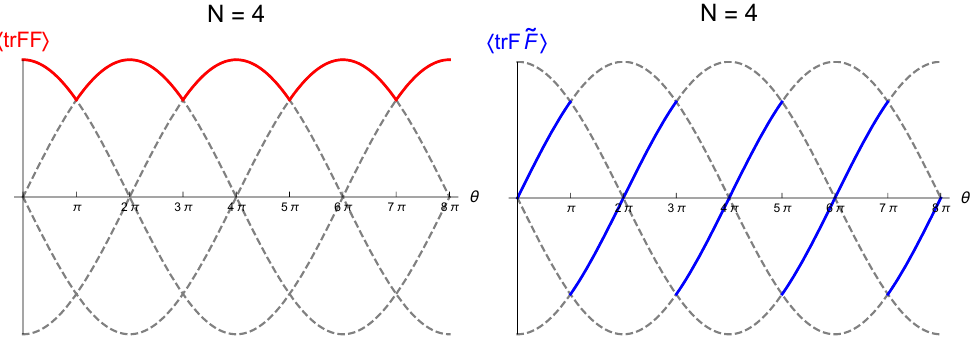
Figure 2 . [Color Online.] A sketch of the (cid:18) angle dependence of the lowest-dimension non-trivial parity even and odd condensate h 1 tr F (cid:22)(cid:23) F (cid:22)(cid:23) i ( (cid:18) ) and h 1 tr F (cid:22)(cid:23) e F (cid:22)(cid:23) i ( (cid:18) ) for N = 4 in SU( N ) YM N N theory in the semiclassical con(cid:12)ning domain. The continuous bold red curve shows the values of the parity-even condensate, while the saw-tooth bold blue curves denote the values of the parity- odd condensate. The grey dashed curves mark the values of the condensates on the N di(cid:11)erent (cid:18)